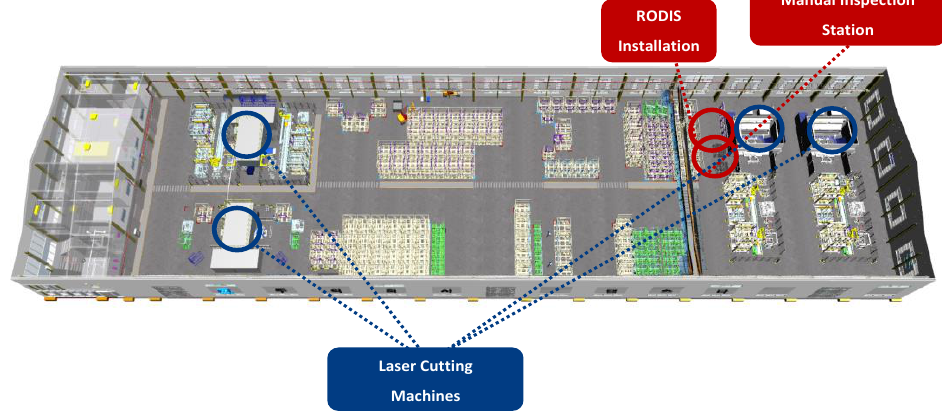
Figure 6. Telstar plant 3D layout and RODIS